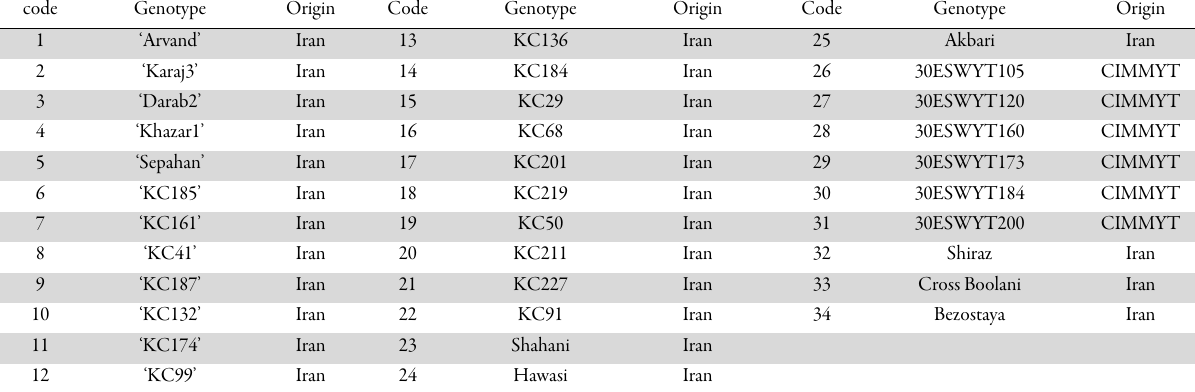
Table 1. List of 34 hexaploid wheat genotypes (landraces and cultivars) used to evaluate drought stress response code